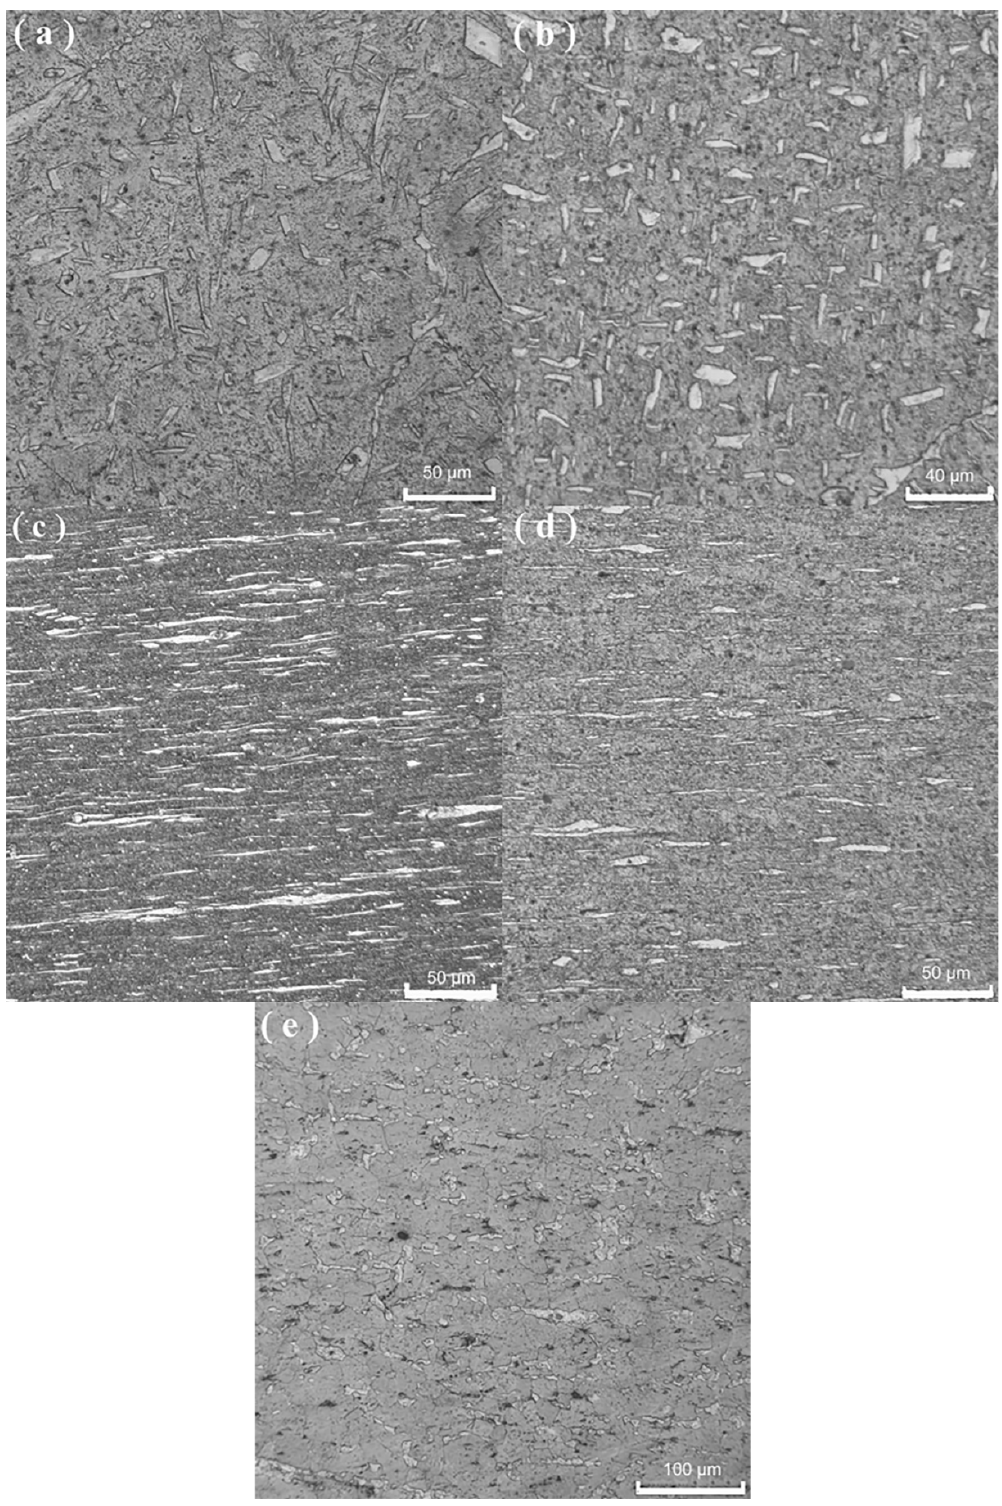
Figure 2. Optical microstructures of the present alloy under different processing states: ( a ) as-cast state, ( b ) 6-pass multidirectional forging (523 K), ( c ) multidirectional forging (523 K) asymmetric hot rolling (523 K) cold rolling state, ( d ) 448 K × 60 min annealing, and ( e ) gripping section, 573 K × 15 min holding.